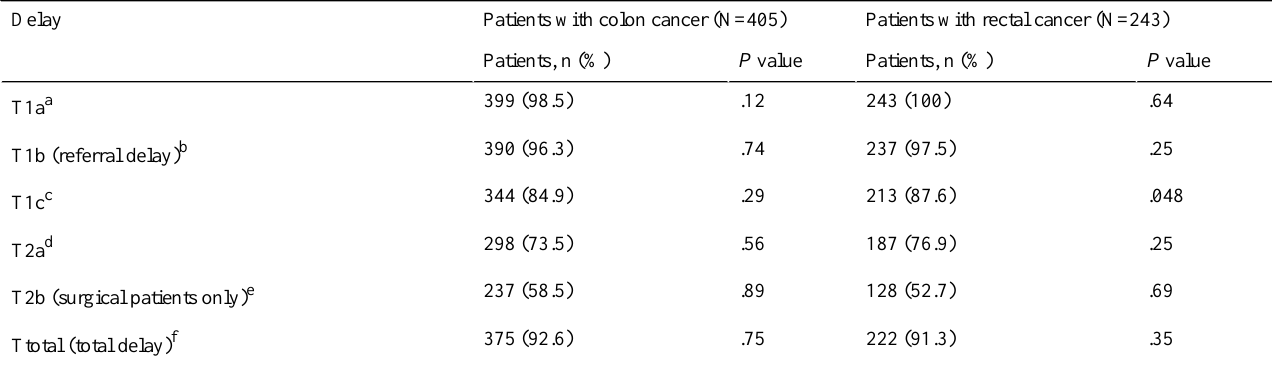
Table 3. Patient numbers and significance values for total delay, referral delay, and delay subdivision analyses.